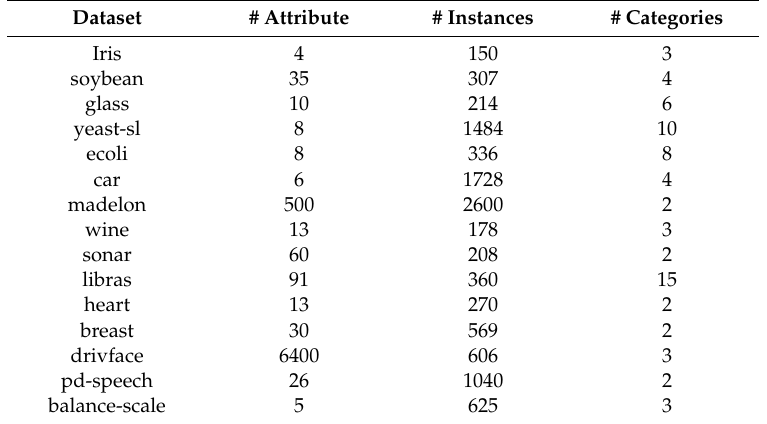
Table 1. Characteristics of the datasets for single-label multi-class